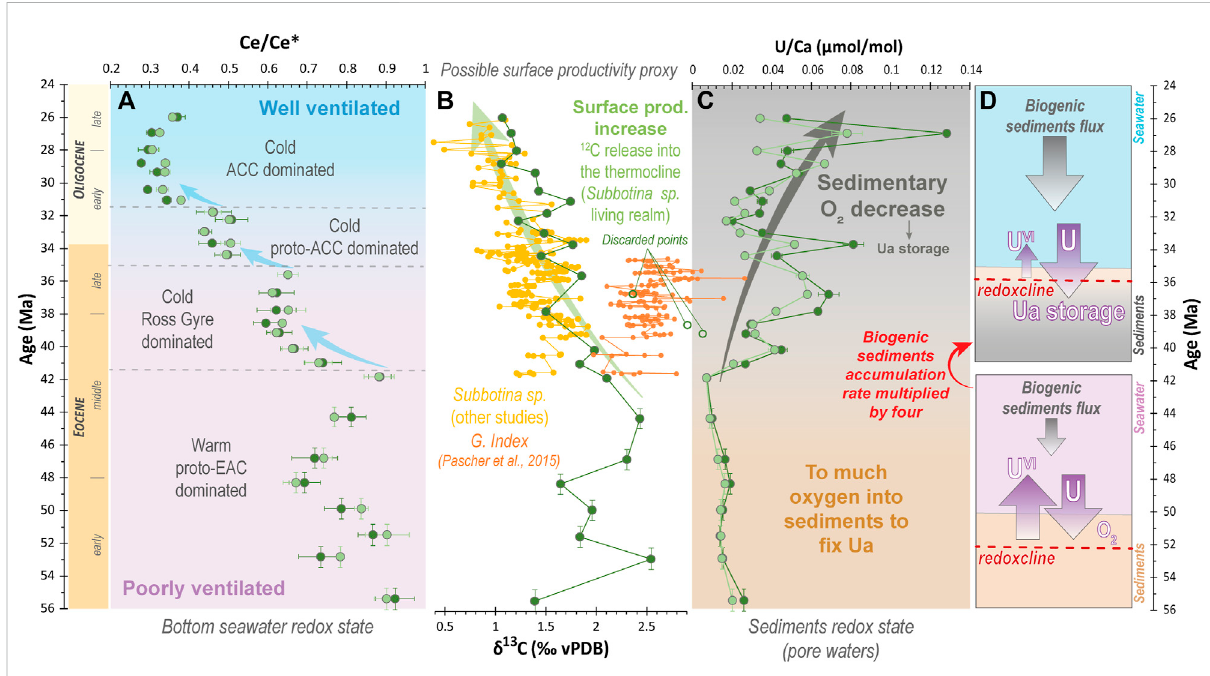
FIGURE 10 Evolution of bottom water redox state, primary productivity, and sediments redox state along the studied time interval. (A) Evolution of the foraminiferal Ce anomaly re fl ecting bottom water conditions. (B) δ 13 C data of thermocline dwelling Subbotina sp. , a possible proxy for surface productivity. Three samples have been discarded because of probable contamination or picking error. We notably suspect accidental picking of surface mixed-layer species instead of Subbotina sp. for these samples given the fact that they fall in the Globigerinatheka index (G. index) composition fi eldinPascher etal. (2015) data.Compiled datafor Subbotinasp. δ 13 C values forSite 277arefrom Keigwin(1980),Murphyand Kennett, 1986, and Pascher et al. (2015). (C) Evolution of foraminiferal U/Ca ratios in Site 277 foraminifera. (D) Scheme of the redoxcline shoaling (allowing